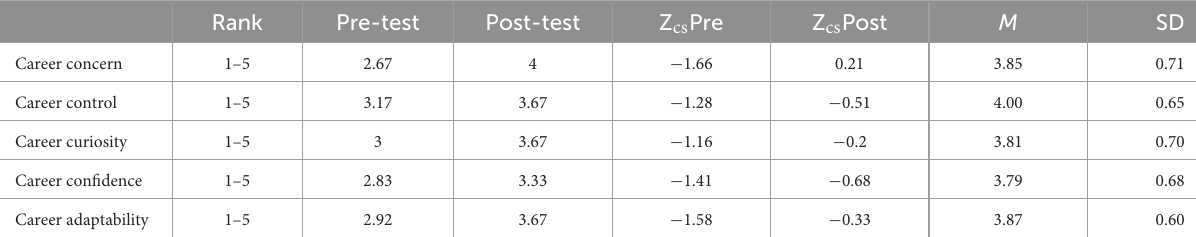
TABLE 4 Pre-test and post-test changes in career